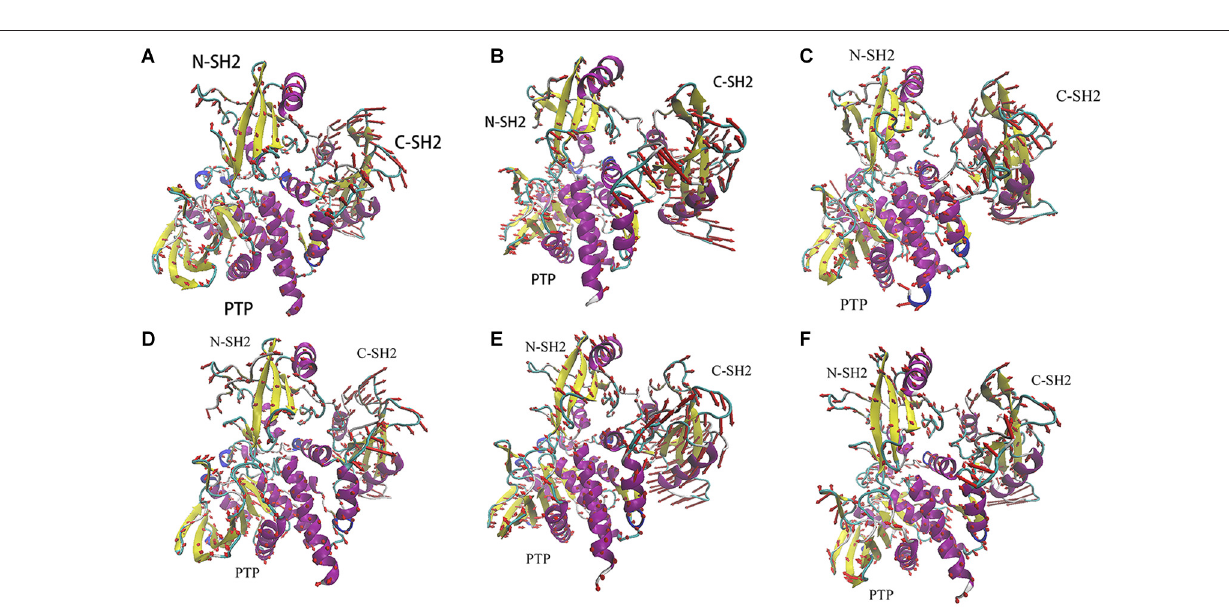
FIGURE 5 | The porcupine plots of system SHP2 (A) , DUAL (B) , N-SH2-ITIM (C) , N-SH2-ITSM (D) , C-SH2-ITIM (E) , and C-SH2-ITSM (F)